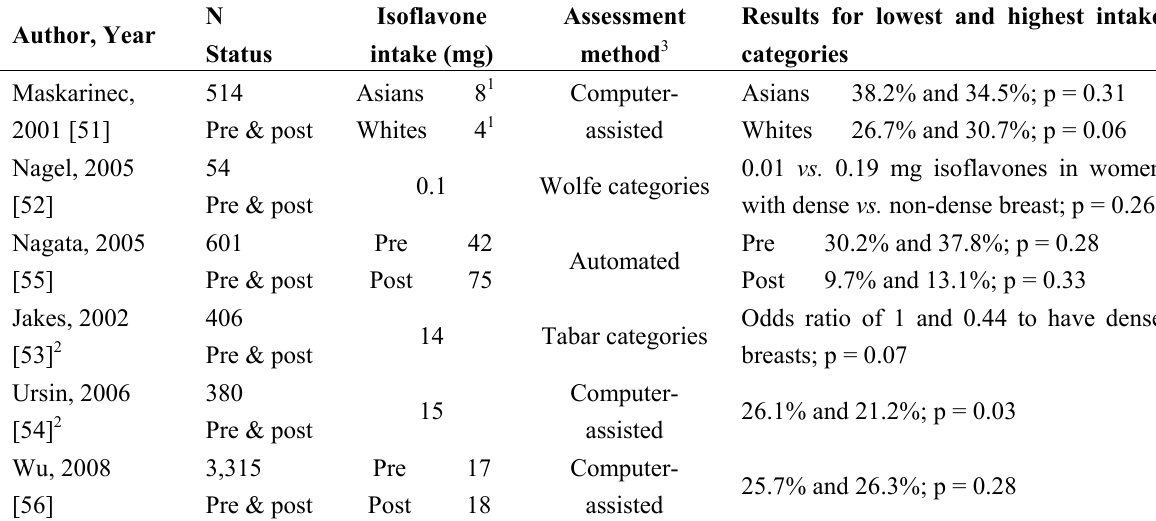
Table 1. Cross-sectional studies on soy/isoflavones and mammographic densities.